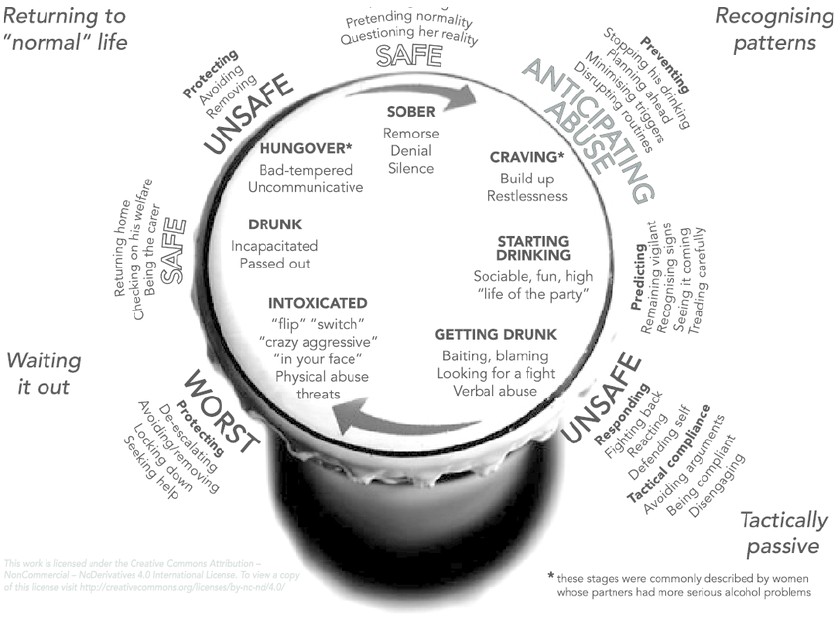
Figure 1: A visual presentation depicting the cycle of alcohol-related intimate partner violence; Source: Wilson, Graham & Taft, 2017, p.120).